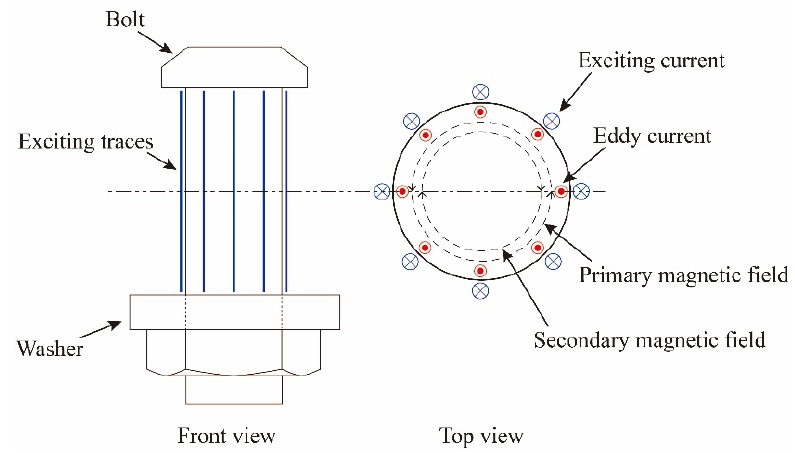
Figure 4. Schematic of eddy current effect.